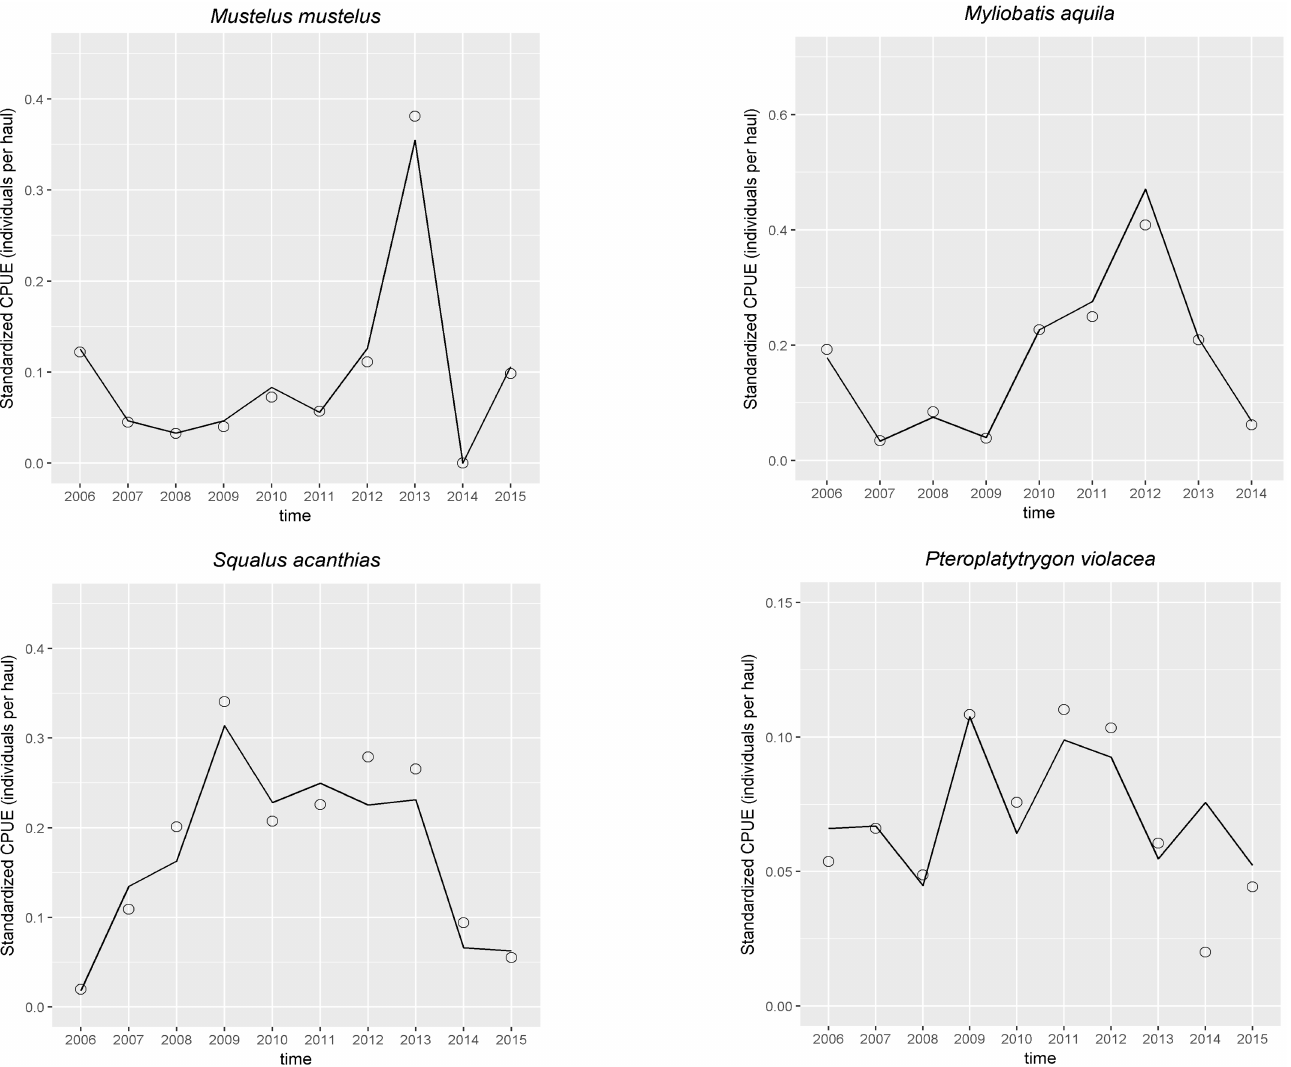
Fig 2. Results of CPUE standardization of Mustelus mustelus (a), Squalusacanthias ,(b), Myliobatis aquila (c), and Pteroplatytrygon violacea (d). Empty dots represent annual nominal CPUE and solid lines represent annual standardized CPUE.